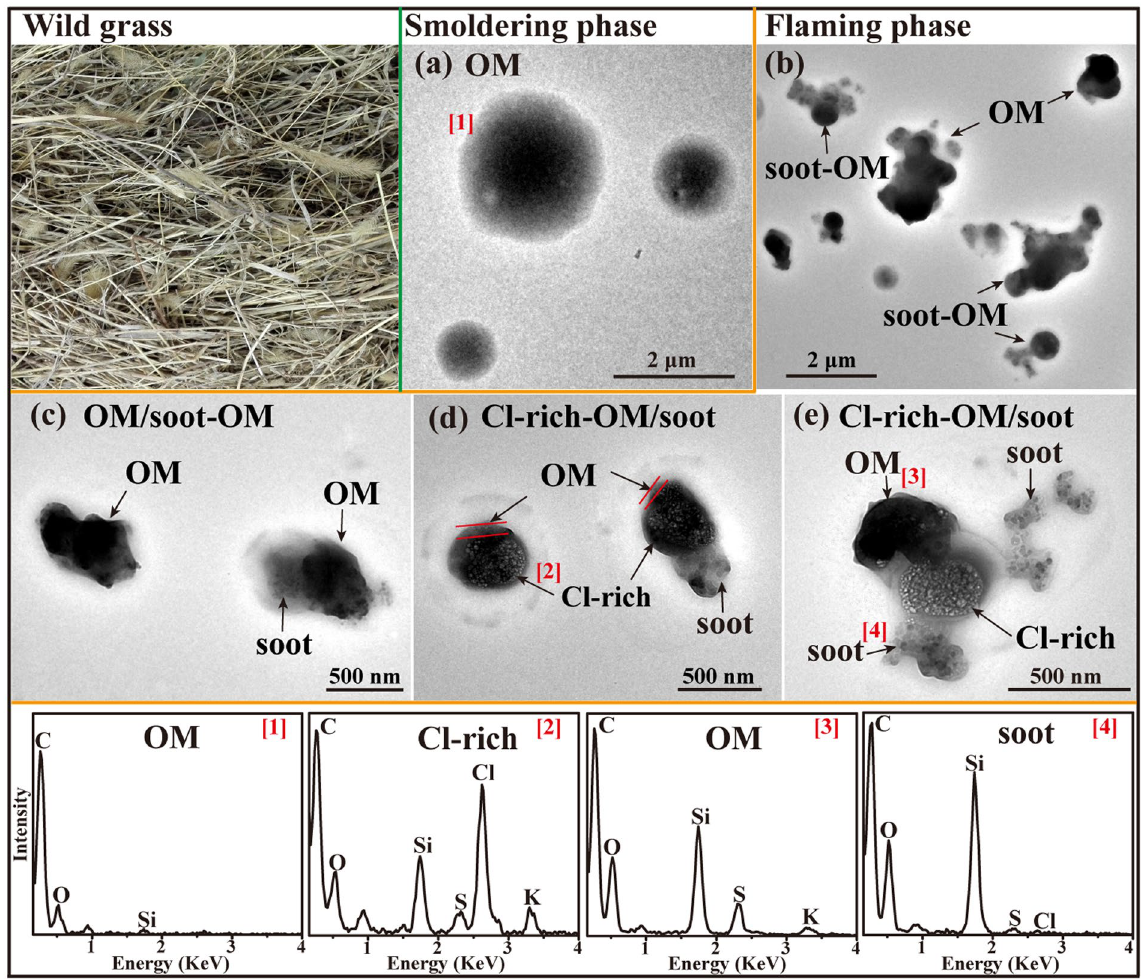
Figure 4. TEM images and EDS spectra of individual primary particles from the combustion of wild grass. ( a ) Low magnification TEM image of the gel-like OM in the smoldering phase; ( b ) Low magnification TEM image of a mixture of OM and soot-OM in the flaming phase; ( c ) Two irrugualr OM and one internally mixed with soot in the flaming phase; ( d ) Two Cl-rich particles with thin OM coating and one internally mixed with soot in the flaming phase; ( e ) An irregular Cl-rich particle internally mixed with OM and soot in the flaming phase. The corresponding EDS spectra are indicated by the number in square brackets.